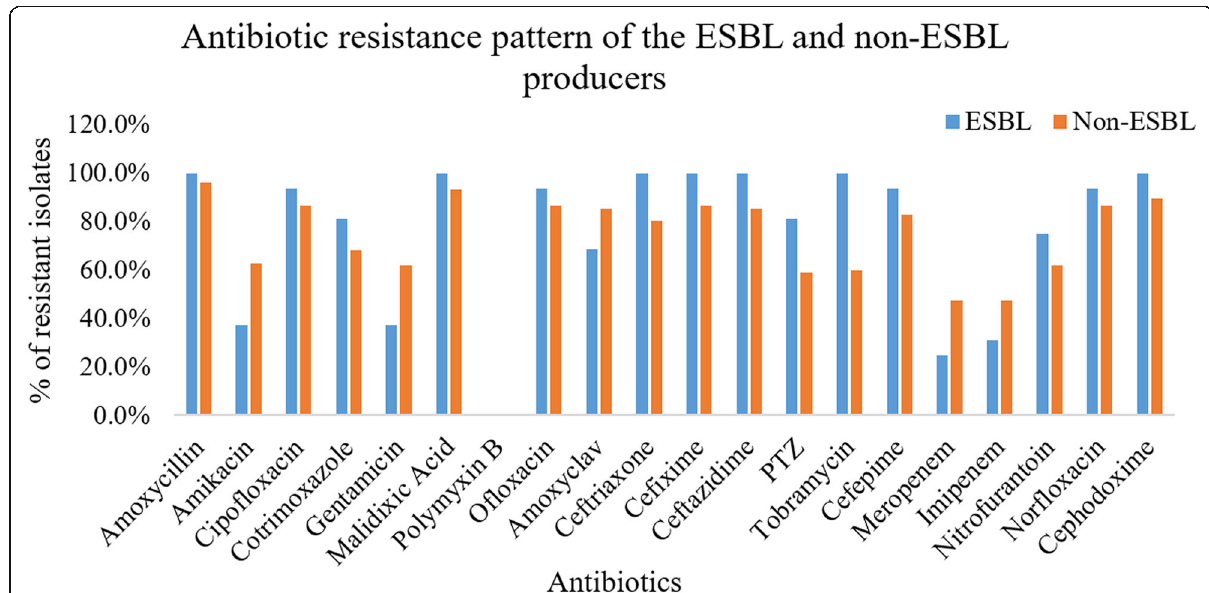
Fig. 1 Antibiotic resistance pattern of the ESBL and non-ESBL